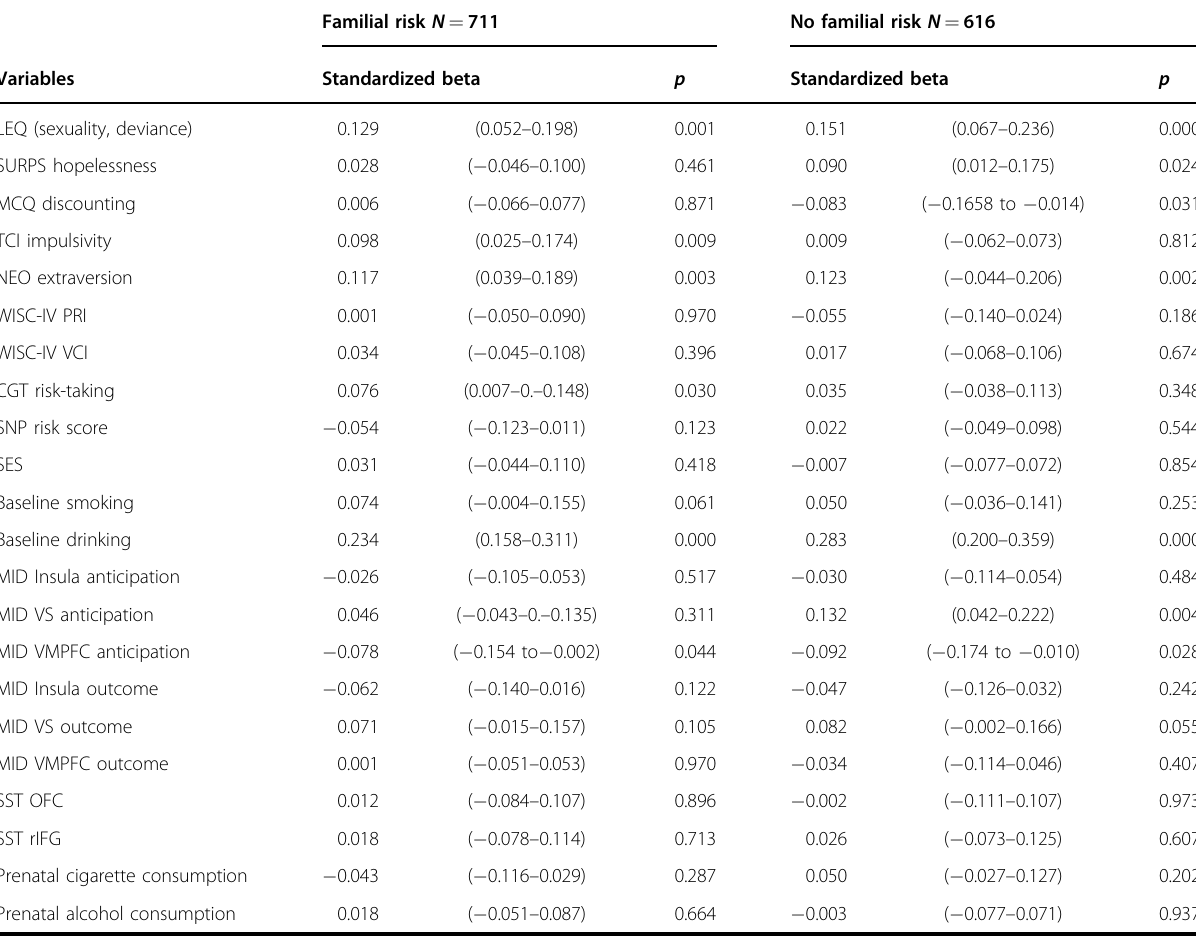
Table 4 Prediction of AUDIT scores at follow-up as a function of familial